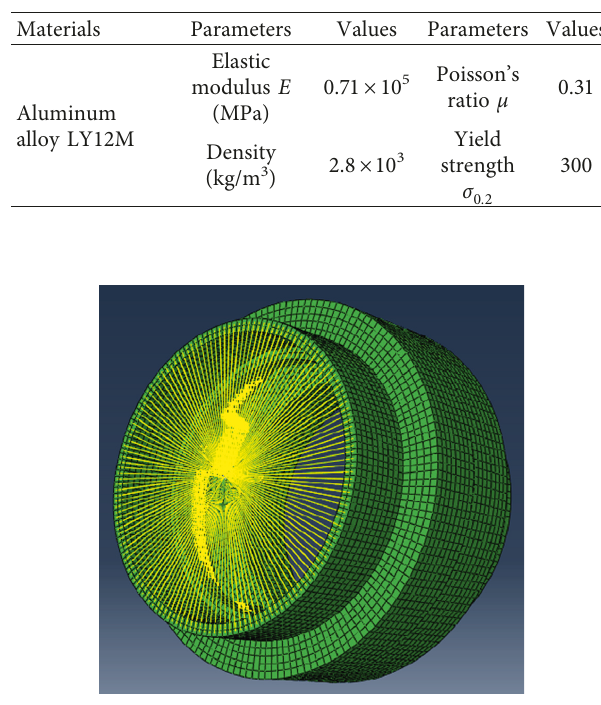
Figure 8: Applied load to the